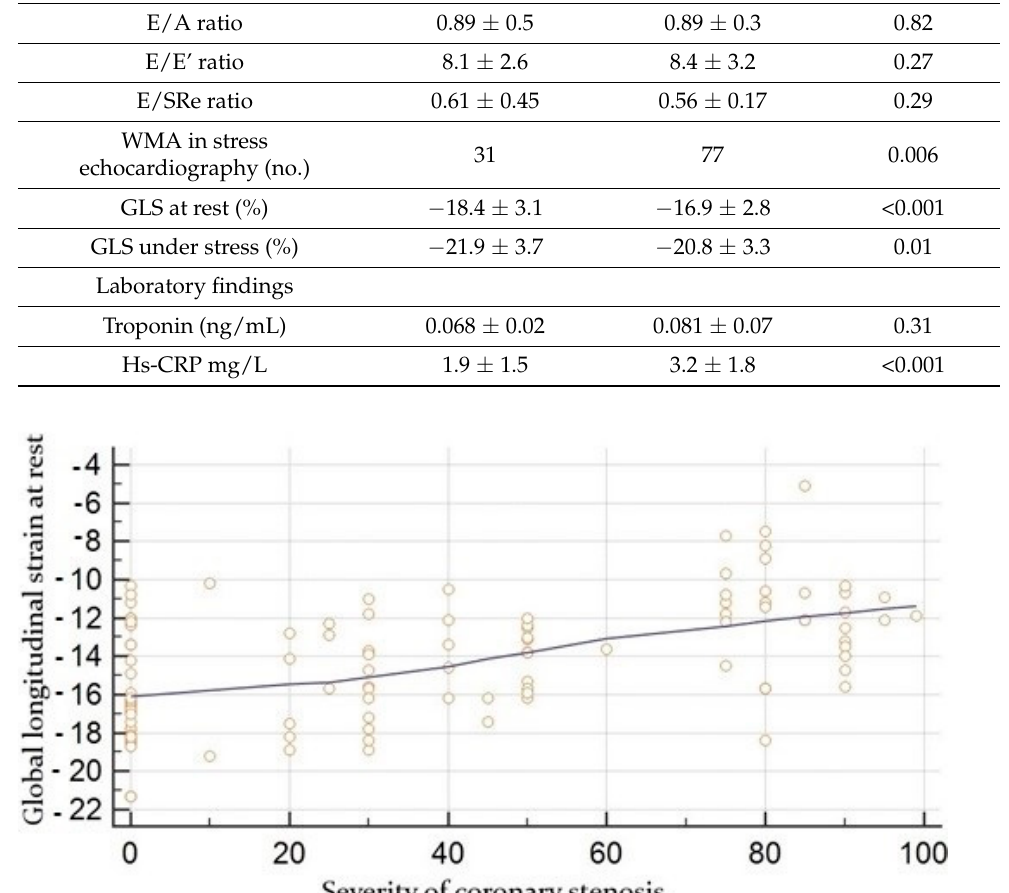
Figure 3. Correlation between global longitudinal strain at rest obtained by speckle tracking (in %) and the angiographic severity of coronary lesion (in %).